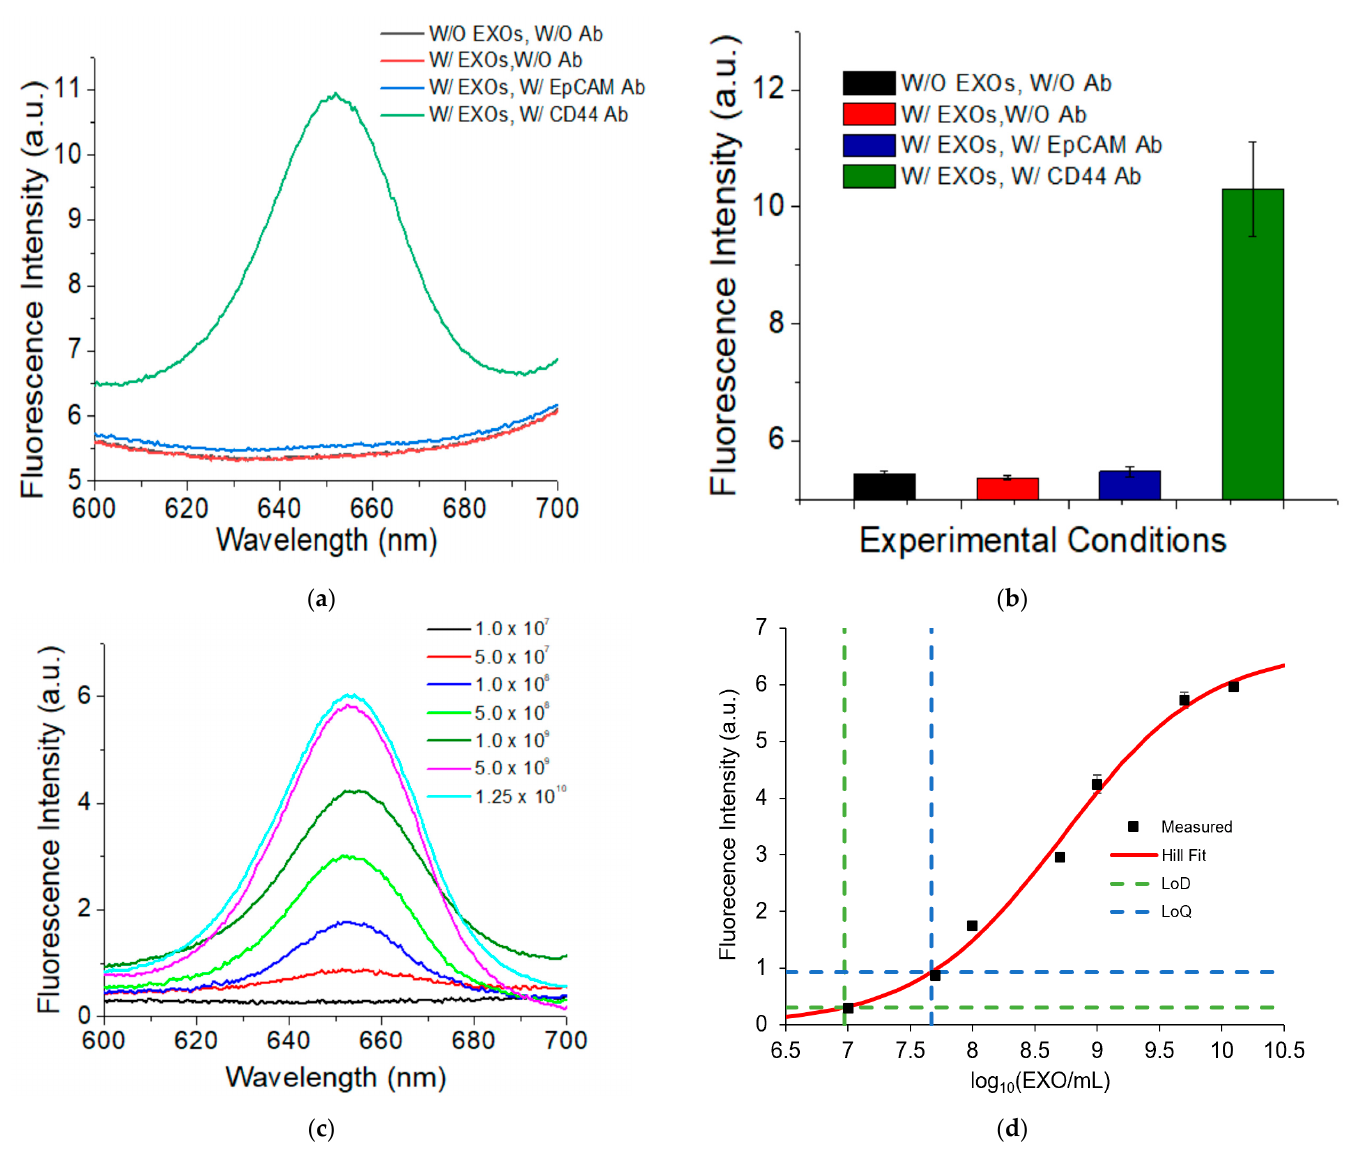
Figure 2. Examination of the specificity ( a , b ) and sensitivity ( c , d ) of the QD-based EXO assay. ( a ) Fluorescence spectra of MDA-MB-231 EXOs treated under four different conditions. ( b ) Intensity plot of ( a ) using the fluorescence intensity at 655 nm. ( c ) Fluorescence spectra of SKBR3 EXOs targeting HER2 at different concentrations. ( d ) Dose–response curve based on data in ( c ) using the fluorescence intensity at 655 nm. Signals were background corrected using the signals without the presence of HER2 primary antibody. Error bar is the standard deviation from triplicate experiments. Ab: antibody.